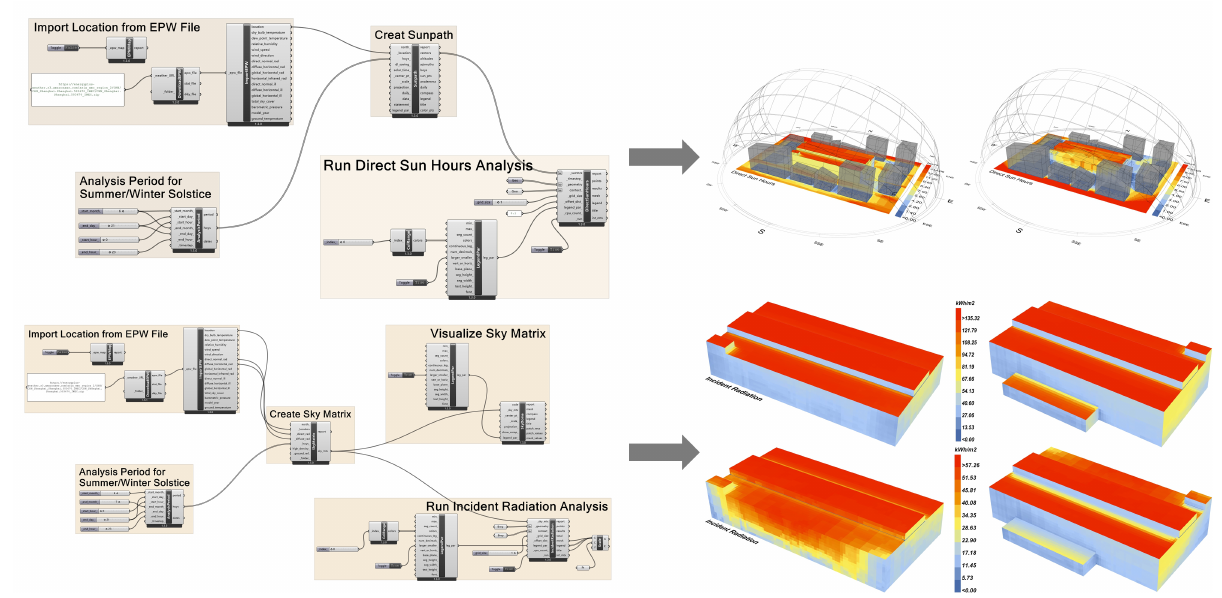
Figure 9. Energy performance analysis.